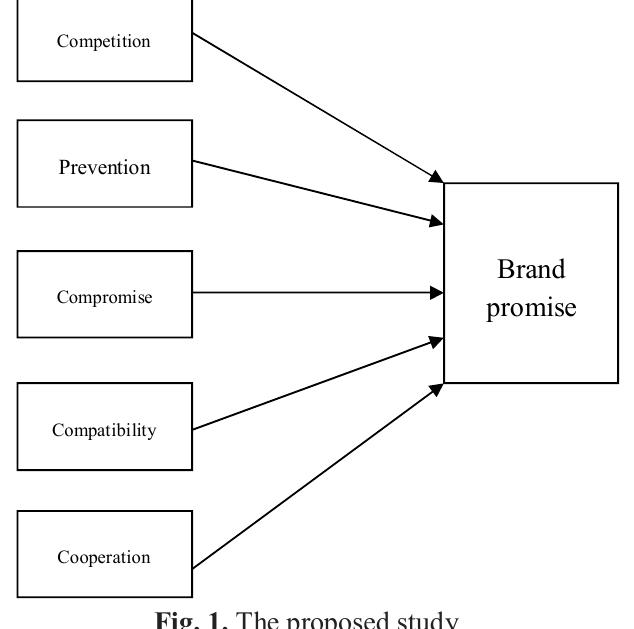
Fig. 1. The proposed